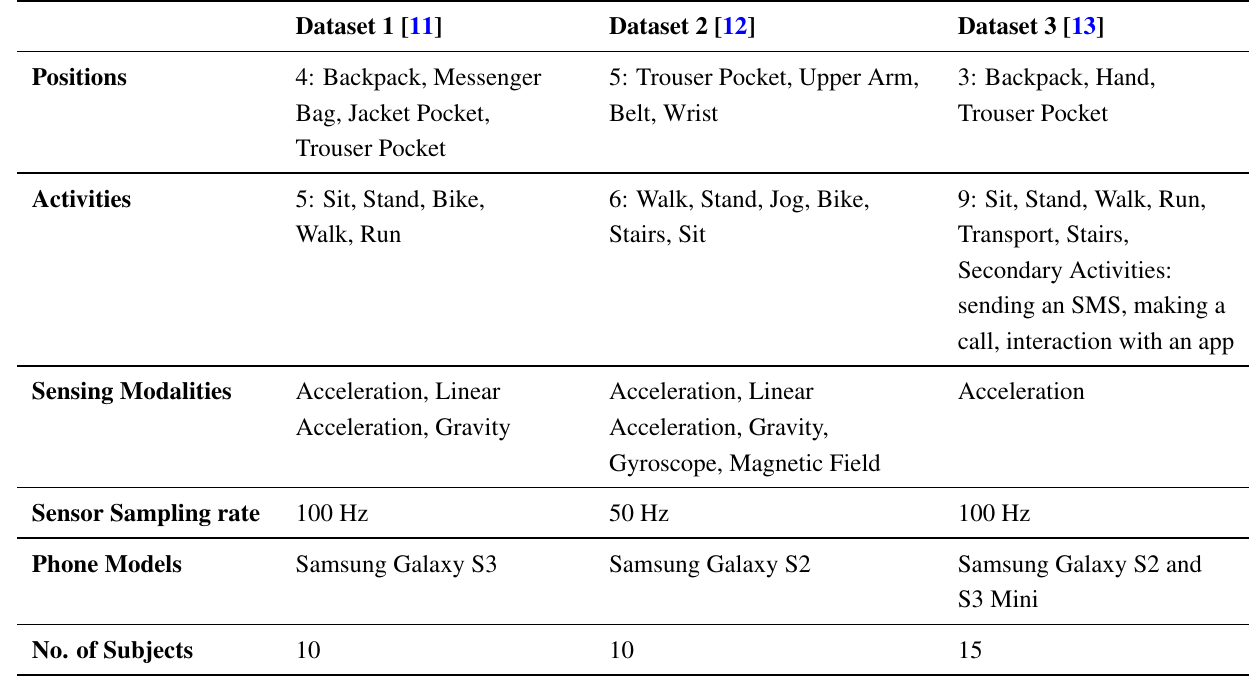
Table 1. Characteristics of the utilized